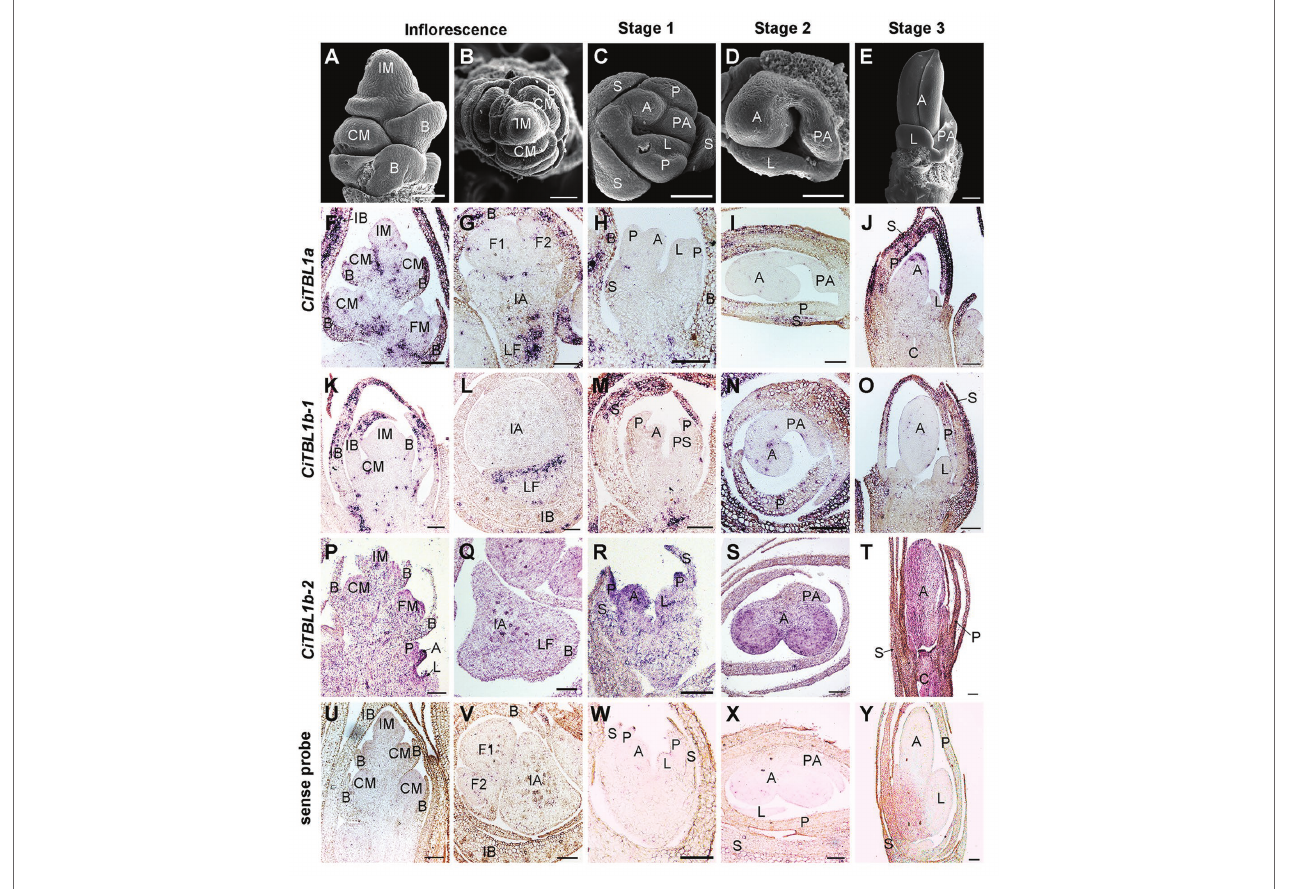
FIGURE 3 | Expression patterns of CiTBL1a , CiTBL1b-1 , and CiTBL1b-2 during inflorescence and early flower developmental stages. (A–E) SEM microphotographs of successive developmental stages. (F–T) RNA in situ hybridizations with antisense probes of (F–J) CiTBL1a , (K–O) CiTBL1b-1 , and (P–T) CiTBL1b-2 . (U–Y) Sections hybridized with CiTBL1b-1 sense probe as negative controls. (G,I,L,Q,S,V,X) were transverse sections, and all the others were longitudinal sections. IB, inflorescence bract; LF, lateral florescence. Bars = 100 μ